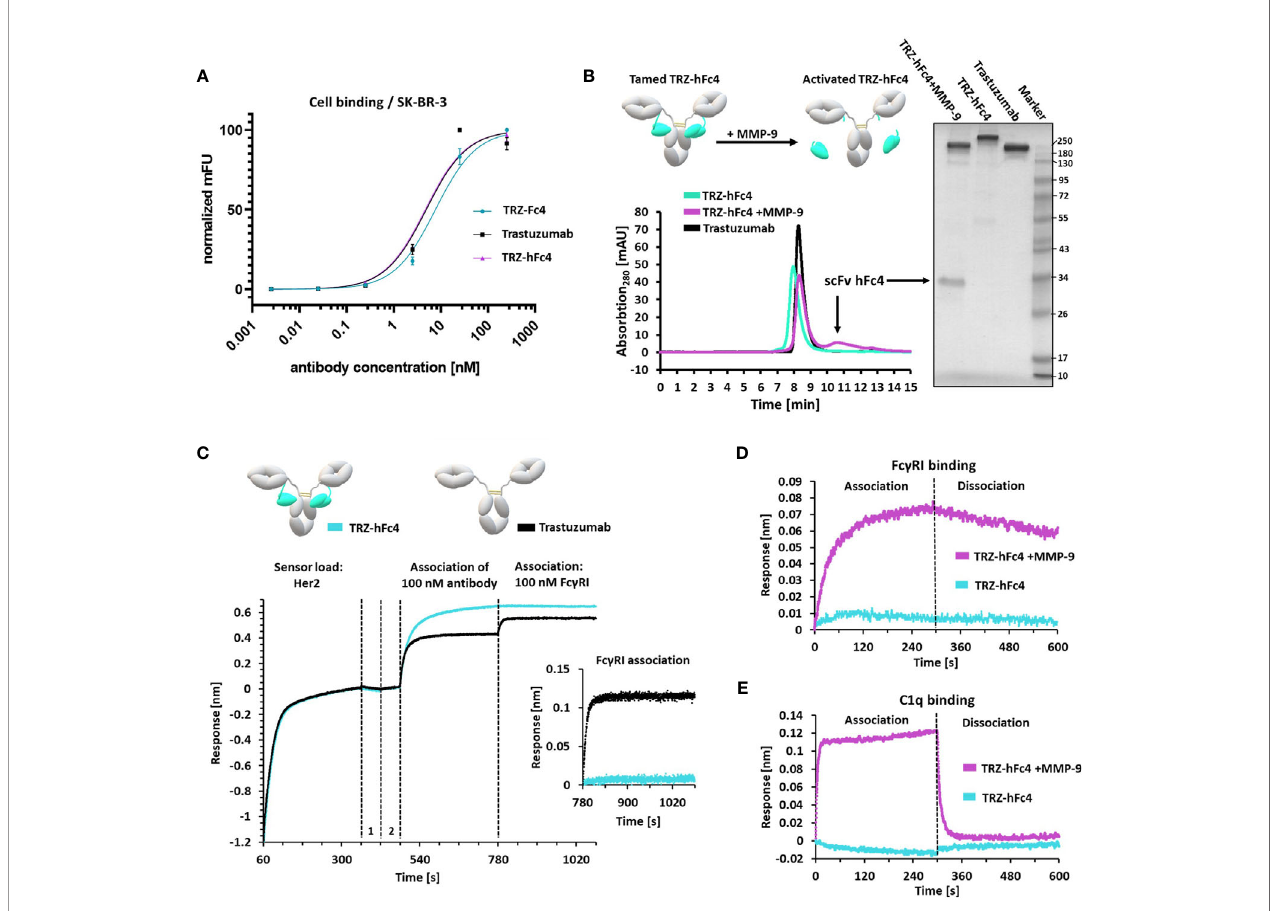
FIGURE 3 | Characterization of tamed Trastuzumab variants TRZ-Fc4, TRZ-hFc4. (A) Flow-cytometry analysis using Her2-positive SK-BR-3 cells. Antibody binding was detected using anti-human kappa PE detection antibody. K D (SK-BR-3 cell binding) including 95%-con fi dence interval analyzed via fl ow-cytometry. Error bars represent standard deviation derived by experimental duplicates. (B) Protease cleavage of TRZ-hFc4 by MMP-9 con fi rmed by SEC and non-reducing SDS-PAGE (4- 15% polyacrylamide). (C) BLI epitope binning. Biotinylated Her2 was loaded onto SAX sensor tips. Two quenching steps (1, 2) were performed, followed by association of 100 nM trastuzumab or TRZ-hFc4. A subsequent association step was performed using 100 nM Fc g RI. A detailed view of the Fc g RI association step (second 780-1080) is shown. All association steps were performed in kinetics buffer. (D) Association and dissociation of 50 nM Fc g RI to TRZ-hFc4 and MMP-9 treated TRZ-hFc4. (E) Association and dissociation of 100 nM c1q to TRZ-hFc4 and MMP-9 treated